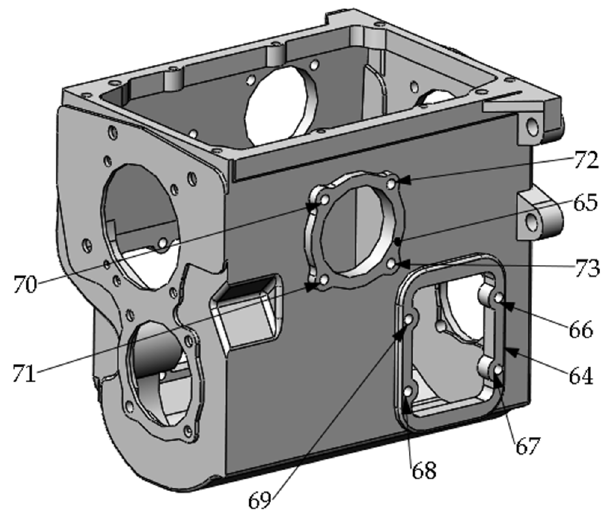
Figure A5. Machining tasks on Right surface.